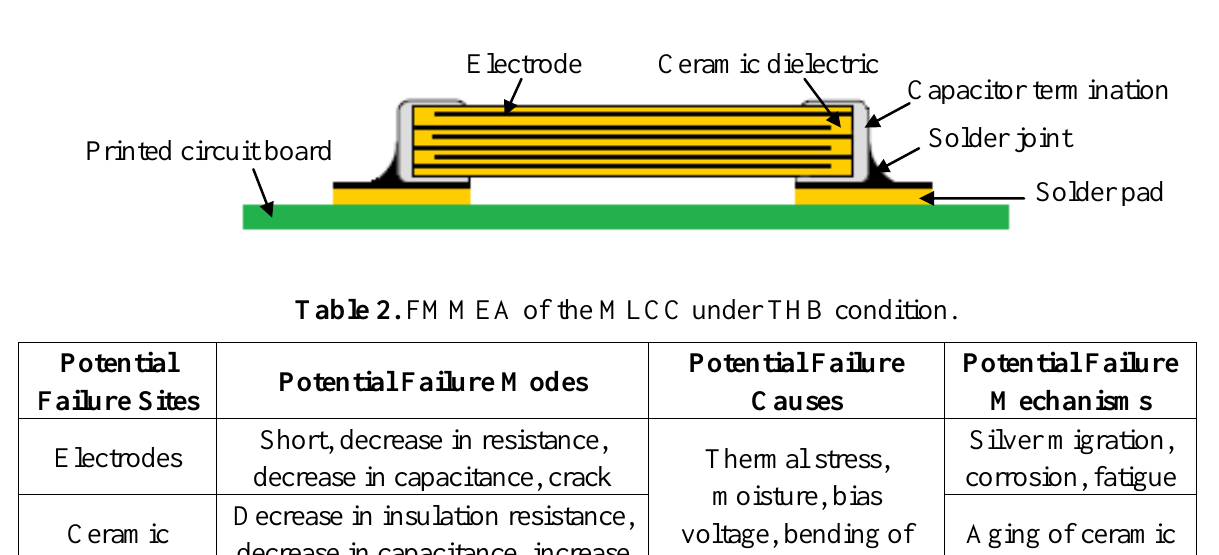
Figure 4. Schematic figure of PME-based MLCC [21].